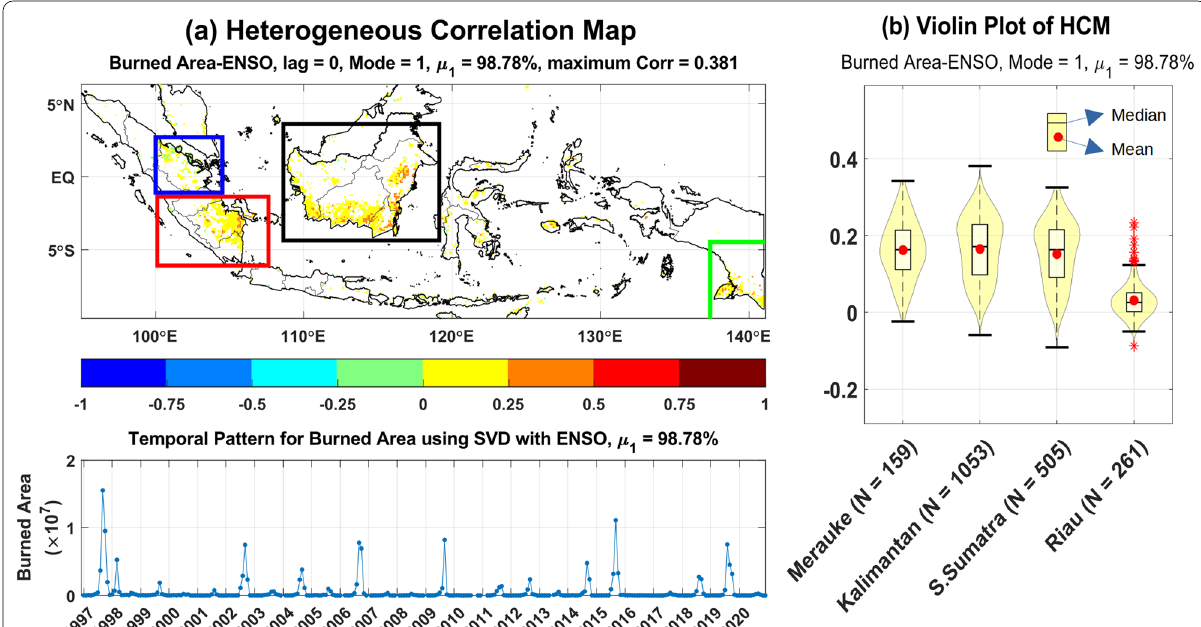
Fig. 1 The correlation map between burned area and ENSO: a the HCM and burned area principal temporal pattern b violin plot of correlation coefficient on Riau (blue box), South Sumatra (red box), Kalimantan (black box), and Merauke (green box). Red dots and stars represent the average value and outlier of correlation distribution in each